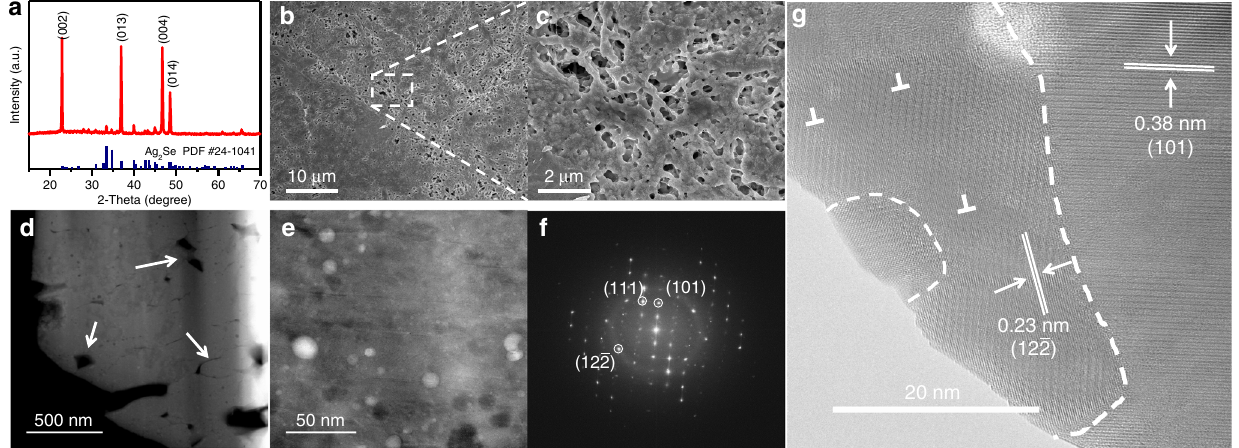
Fig. 1 Characterization of the Ag 2 Se fi lm. a XRD pattern of the Ag 2 Se fi lm. b Low magni fi cation surface FESEM image of the Ag 2 Se fi lm. c High magni fi cation surface FESEM image of the Ag 2 Se fi lm. d Overview HAADF-STEM image. e Typical STEM image. f FFT image corresponding to e . g Typical